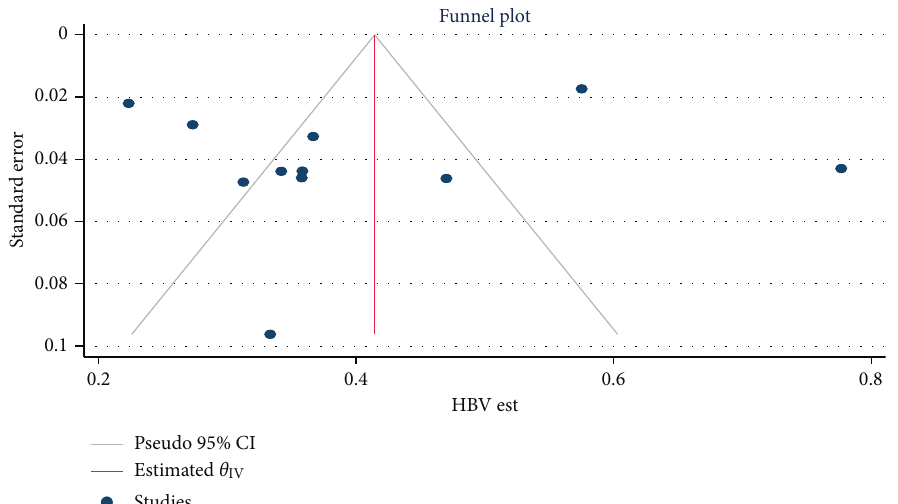
Figure 2: Funnel plot for assessing publication bias across HBV estimates among chronic liver disease patients in Ethiopia,